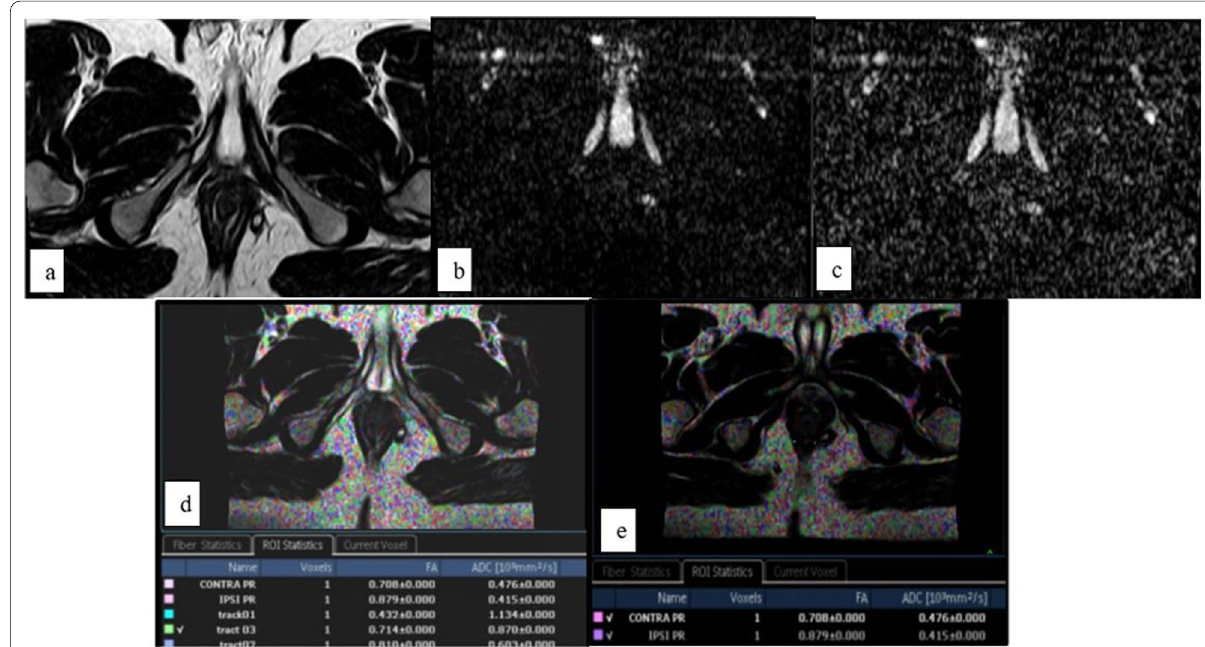
Fig. 8 a axial T2WI, b DWI and c ADC maps for a trans-sphincteric track breaching the sphincter at 3 O’ clock showing bright T2, DWI WI and ADC map signal indicating absence of true diffusion restriction with being clinically inactive with high FA and ADC values as shown in axial DTI/T2 fused images with ROI (FA and ADC) values placed in the trans-sphincteric track ( d ), ipsilateral and contralateral sphincters e with FA values 0.714, 0.879, and 0.708 and ADC values 0.870, 0.415 and 0.476 103 mm 2 /s, ×